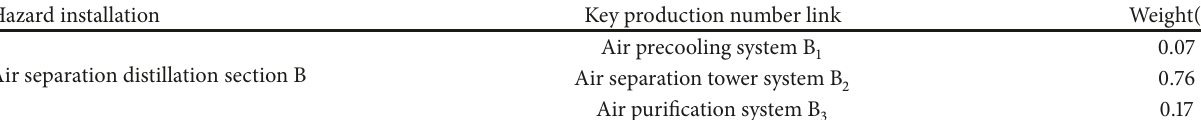
Table 12: Level weight